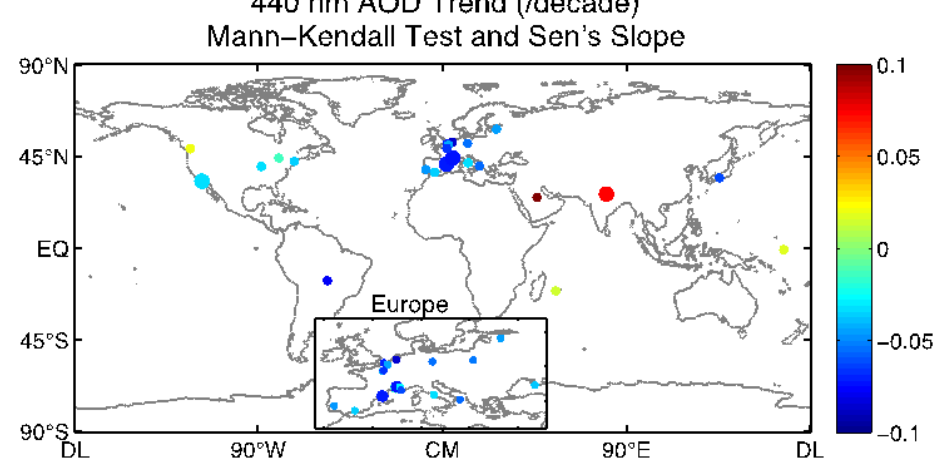
Figure 4. Global map showing the magnitude and significance of the 440nm AOD trends. Only statistically significant ( > 90%) trends are shown. The smaller dots indicate trends at 90% significance, while larger dots indicate trends at 95% significance. The magnitude of the trend (decade − 1 ) is indicated by the color of the dots, following the color scale on the right. The small panel at the bottom is an enlarged map of